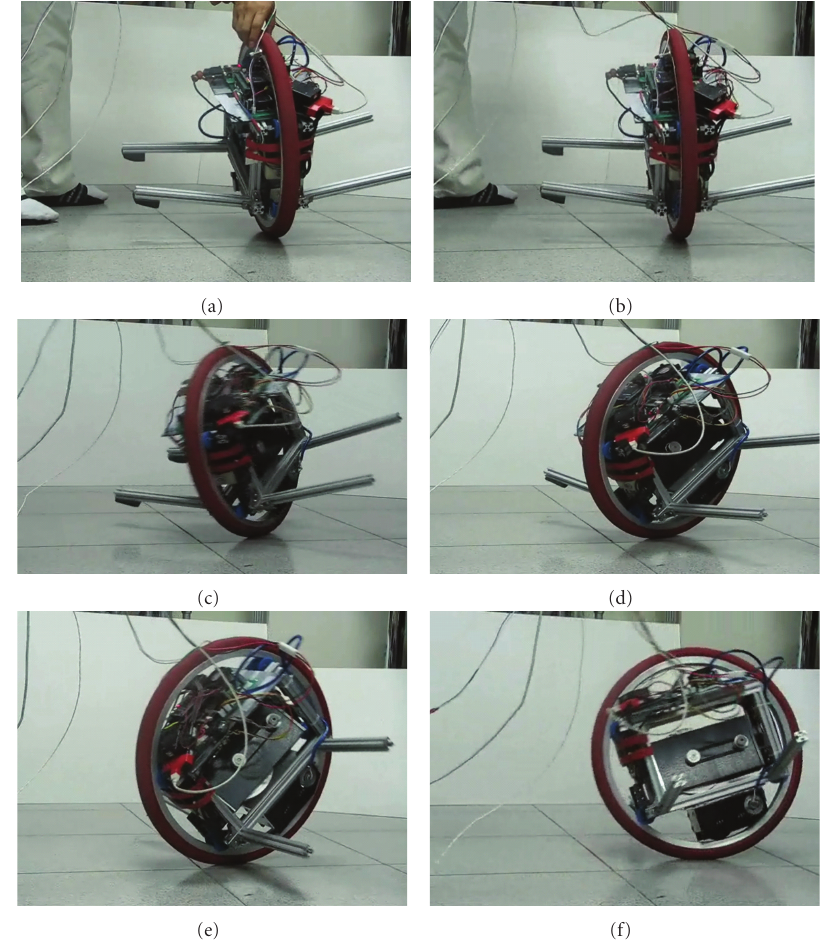
Figure 14: PD control: balancing task (a-b-c-d-e-f in